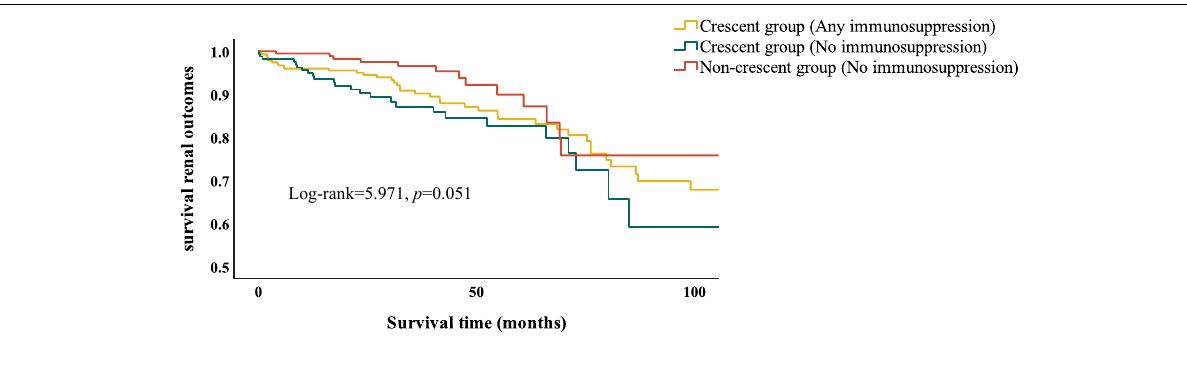
FIGURE 2 | Kaplan Meier survival curve of IgAN patients with or without